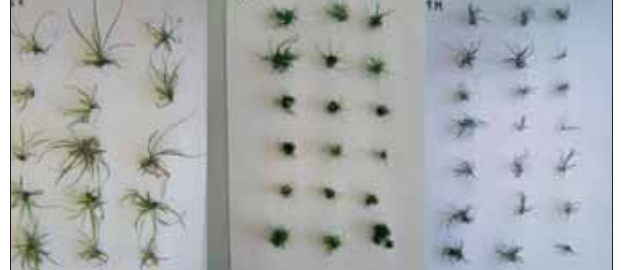
Figure 1. Different morphological characteristics of in vitro Nidularium ’Kertész Jubileum’ plants cultured on medium with different type of cytokinins (K:KIN, A:BA, M: mT)